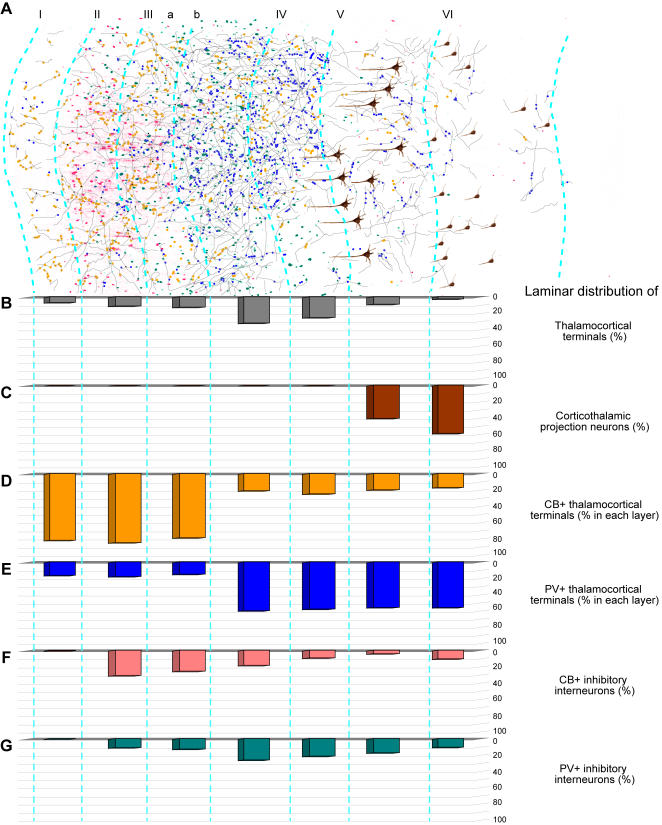
Summary of thalamo-cortical terminals from the ventral anterior nucleus within laminar microenvironments in the prefrontal cortex.
A, Neurolucida drawing of a strip of prefrontal cortex from area 9, showing the distribution of thalamo-cortical axons (grey), CB+ (yellow dots) or PV+ terminals (blue dots), cortico-thalamic projection neurons (brown), and local inhibitory neurons (red for CB+ and green for PV+). B–G, Quantitative laminar distribution (%) of: B, thalamo-cortical terminals; C, cortico-thalamic projection neurons; D, CB+ thalamo-cortical terminals; E, PV+ thalamo-cortical terminals; F, CB+ inhibitory neurons in prefrontal cortex; G, PV+ inhibitory neurons in prefrontal cortex.